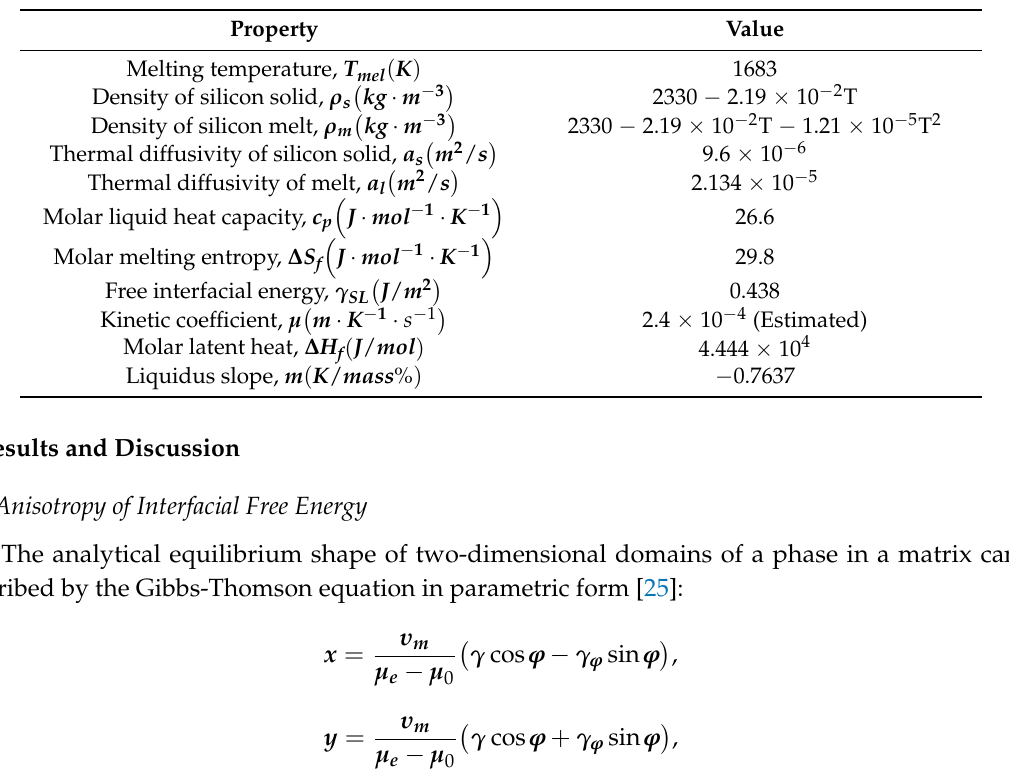
Table 1. Physical properties and calculation parameters used in the present